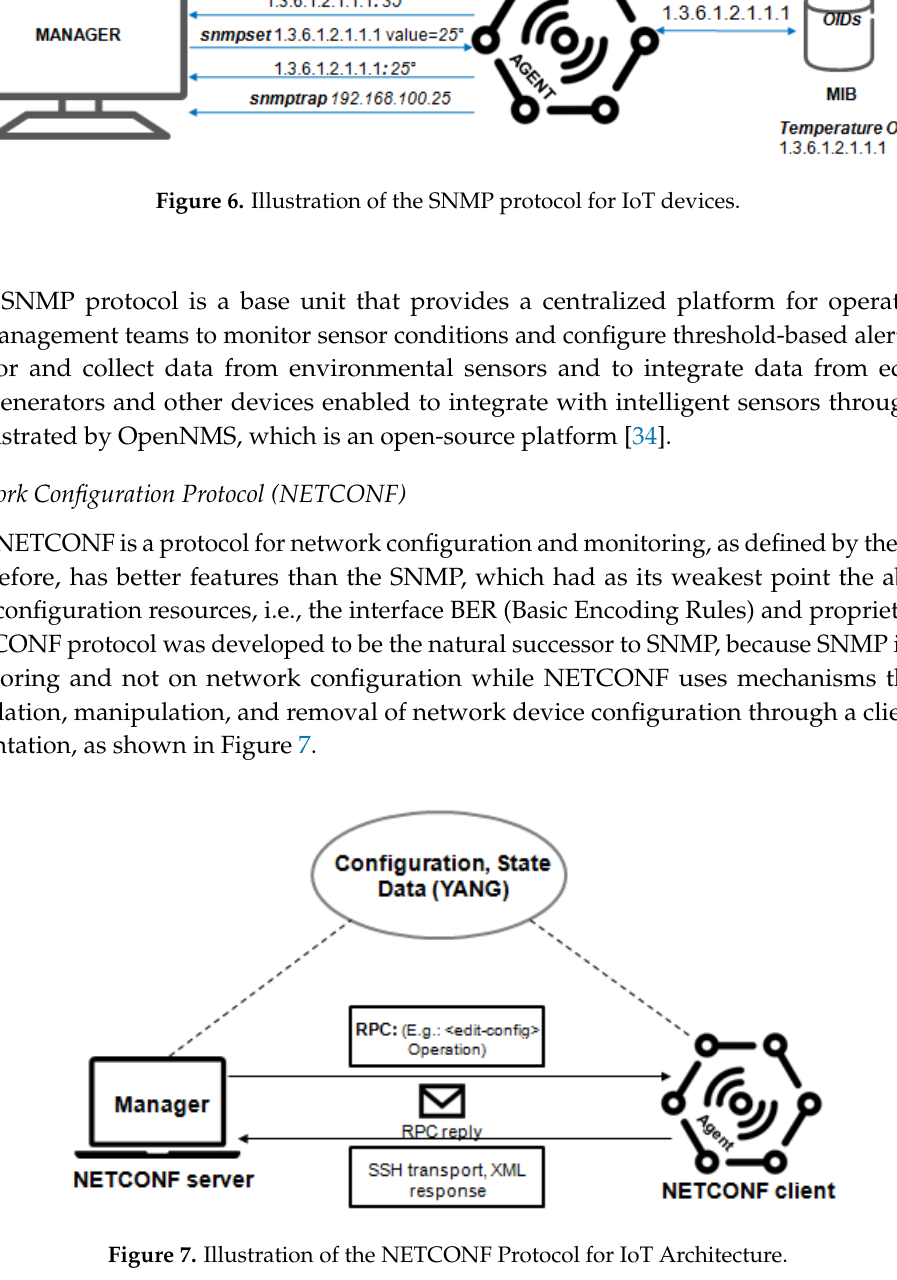
Figure 7. Illustration of the NETCONF Protocol for IoT